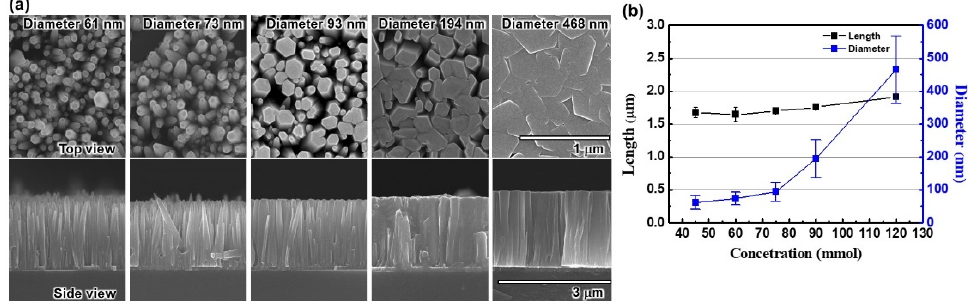
Figure 5. ( a ) SEM characteristics of various diameter- and length-based ZnO nanorods for side and top views, respectively. ( b ) Variation of ZnO nanorod lengths and diameters with the solution con- centration.